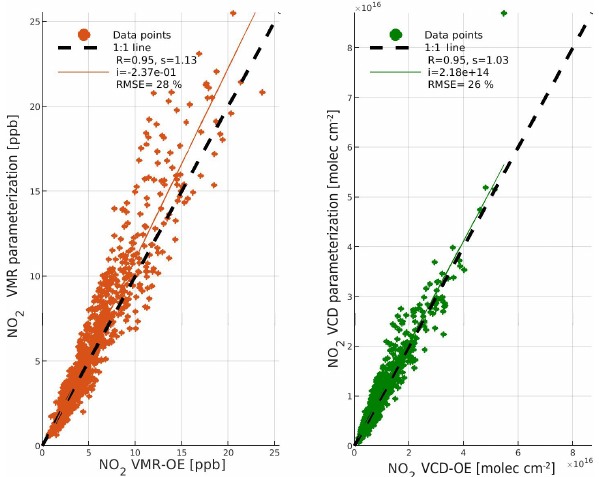
Figure 6. Same as Fig. 5 for the UV channel.